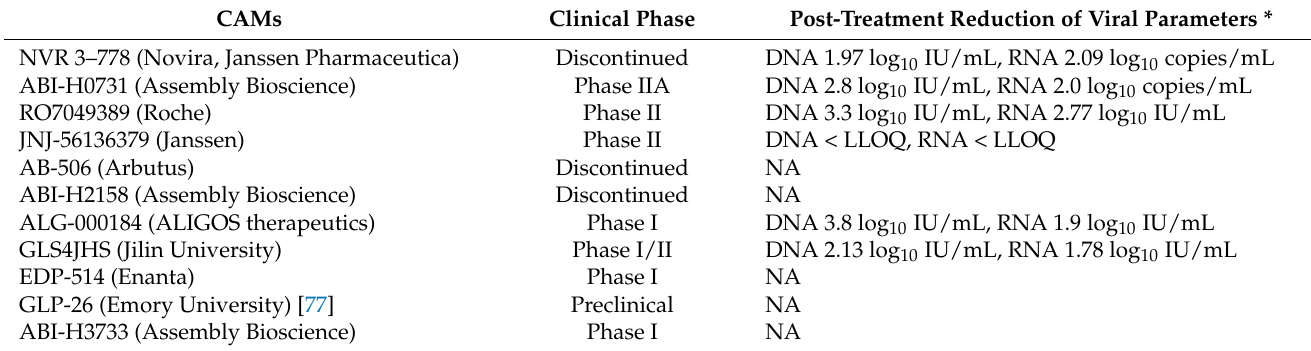
Table 1. List of CAMs in clinical or preclinical development with the associated post-treatment viral parameters in